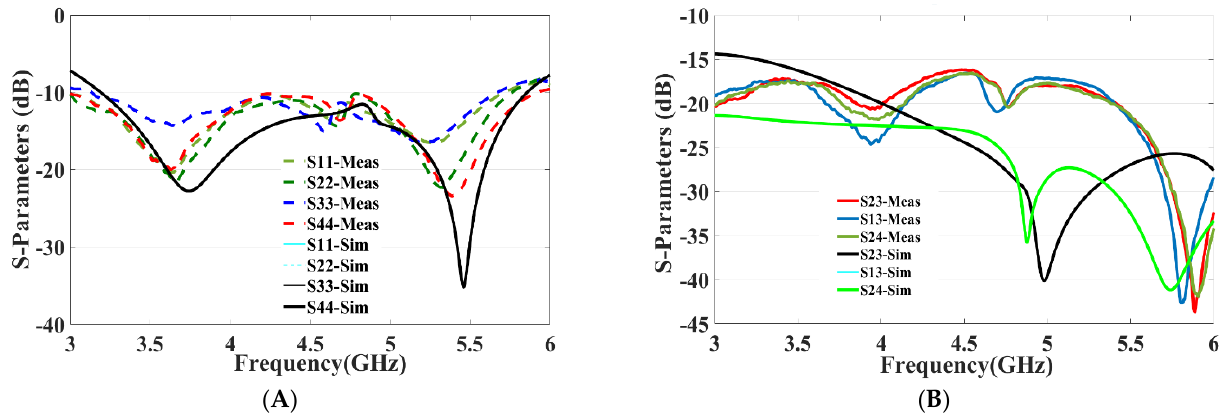
Figure 8. Simulated and measured results of the proposed antenna: ( A ) S 11 , S 22 , S 33 , S 44 and ( B ) S 13 , S 23 , S 23 , S 24 .